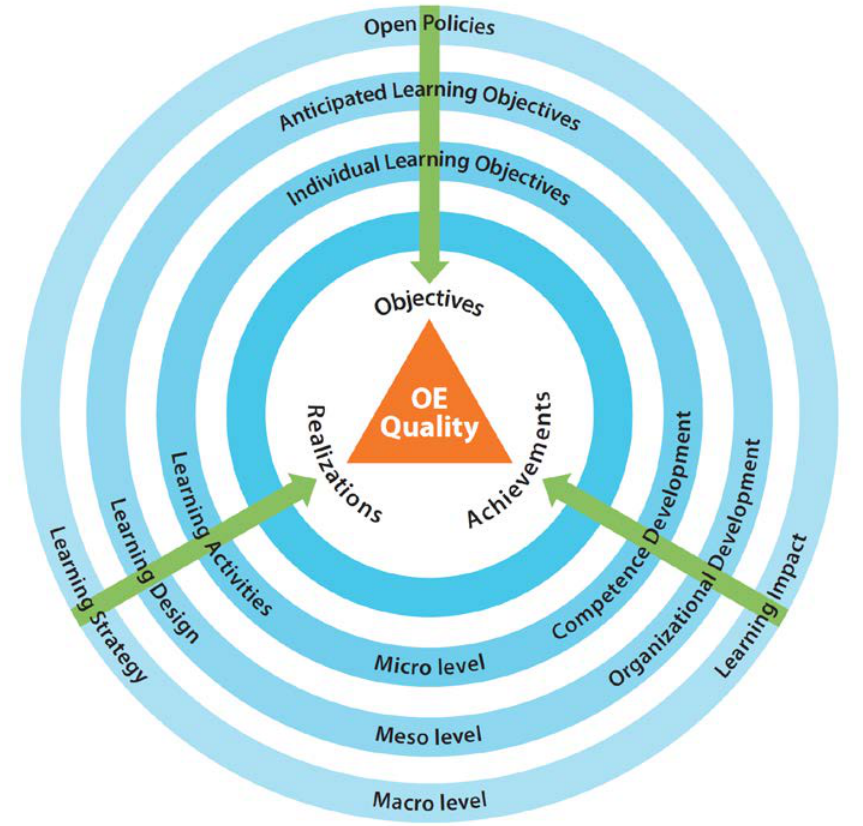
Figure 5 . Quality at macro, meso, and micro level in Open Education.